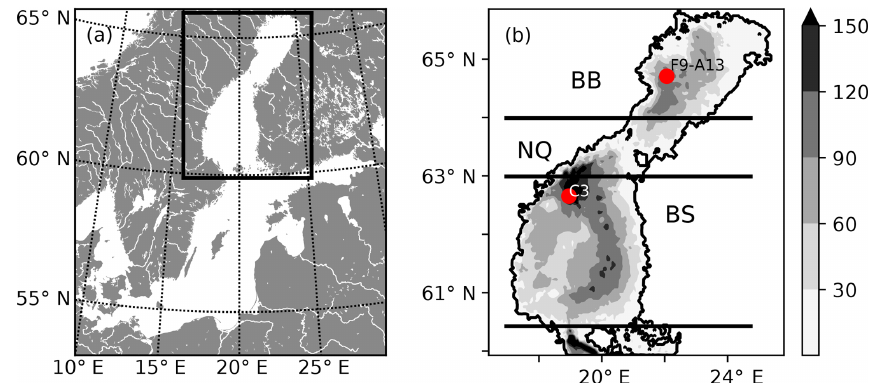
Figure 1. (a) Map of the Baltic Sea. The rectangle marks the location of the Gulf of Bothnia and the model domain. (b) Bathymetric chart of the NEMO-GoB configuration. The filled contours show the depth (m). The horizontal lines mark the borders of the subbasins: the Bothnian Bay (BB), the Northern Quark (NQ) and the Bothnian Sea (BS). The two red dots show the position of two stations that are used for evaluation of the model (Figs. S6–S19 in the